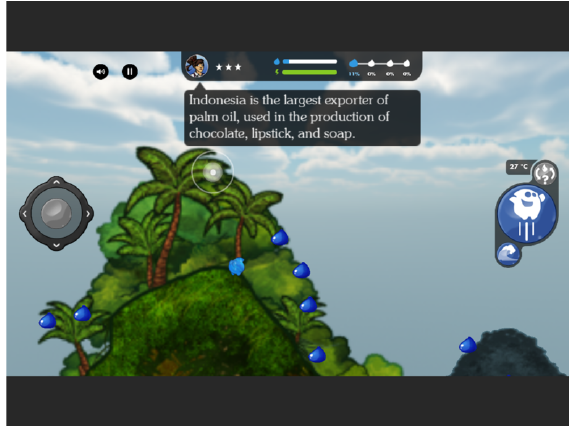
Figure 2. Fact bubbles that appear during gameplay.